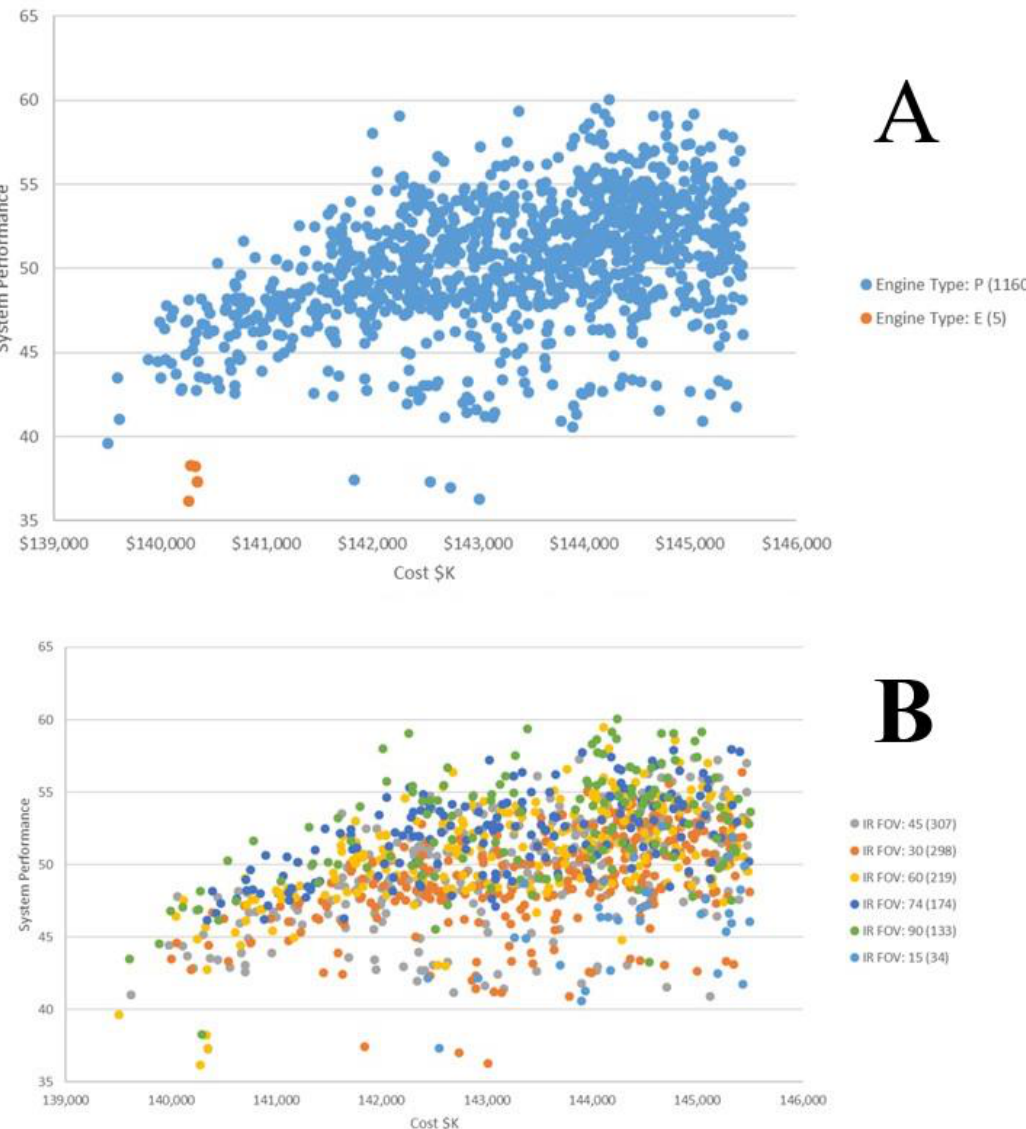
Figure 11. Tradespace Classified by ( A ) Engine Type (top) and ( B ) IR Sensor Field of View